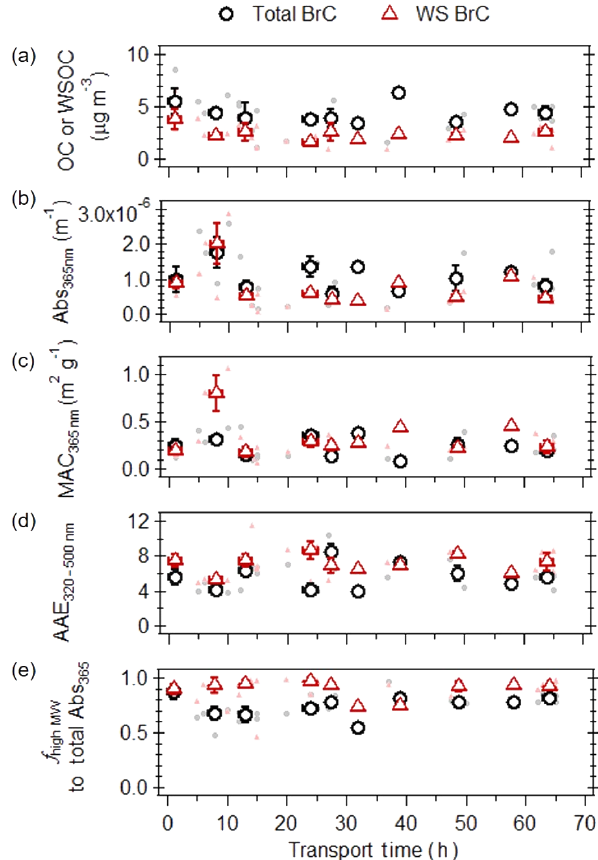
Figure 5. (a) Organic carbon (OC) or water-soluble organic carbon (WSOC) concentrations, (b) light absorption at 365nm, (c) mass absorption coefficients at 365nm, (d) AAE (in the wavelength range of 320–500nm), and (e) fractional contribution of high-molecular- weight fractions to total light absorption as a function of atmo- spheric transport time, for MeOH (black circles) and water (red tri- angles) extractable portion of the ambient filters collected on the island of Crete, Greece, during the 2016 and 2017 fire seasons. The filled points are individual filter measurements, the open points rep- resent the binned median values, and the associated error bars rep- resent the interquartile